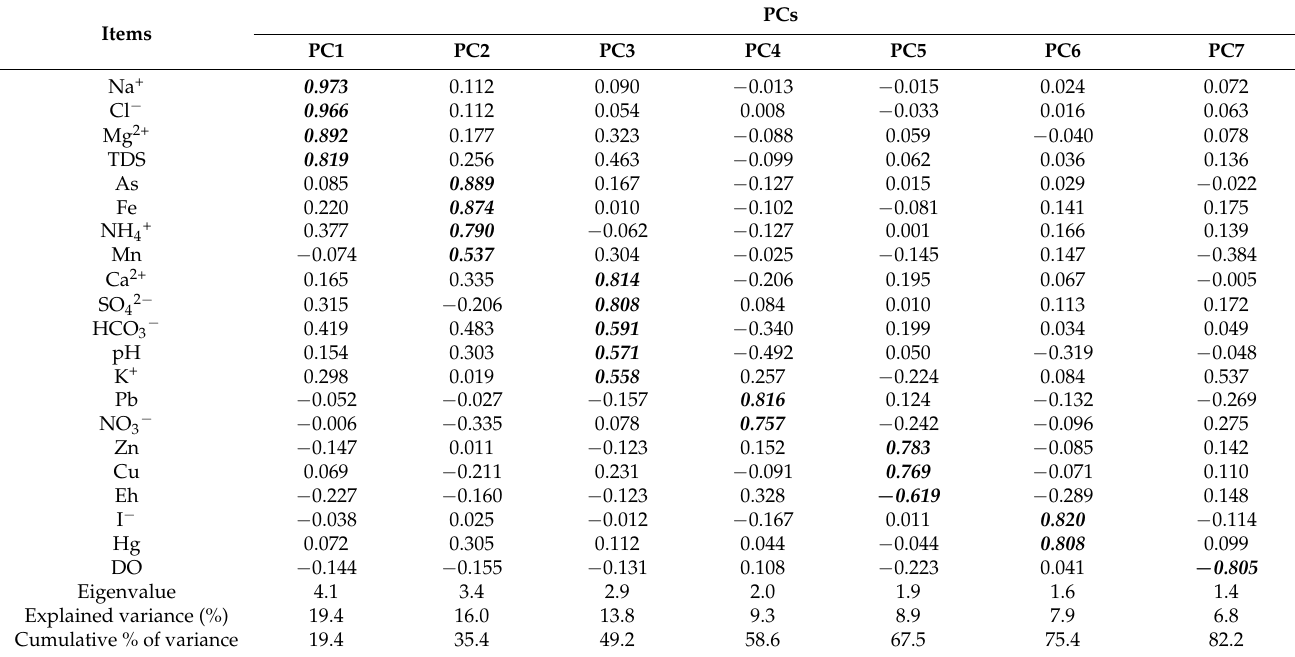
Table 2. Principal component (PC) loadings for groundwater chemistry in porous aquifers in agricultural lands in the Pearl River